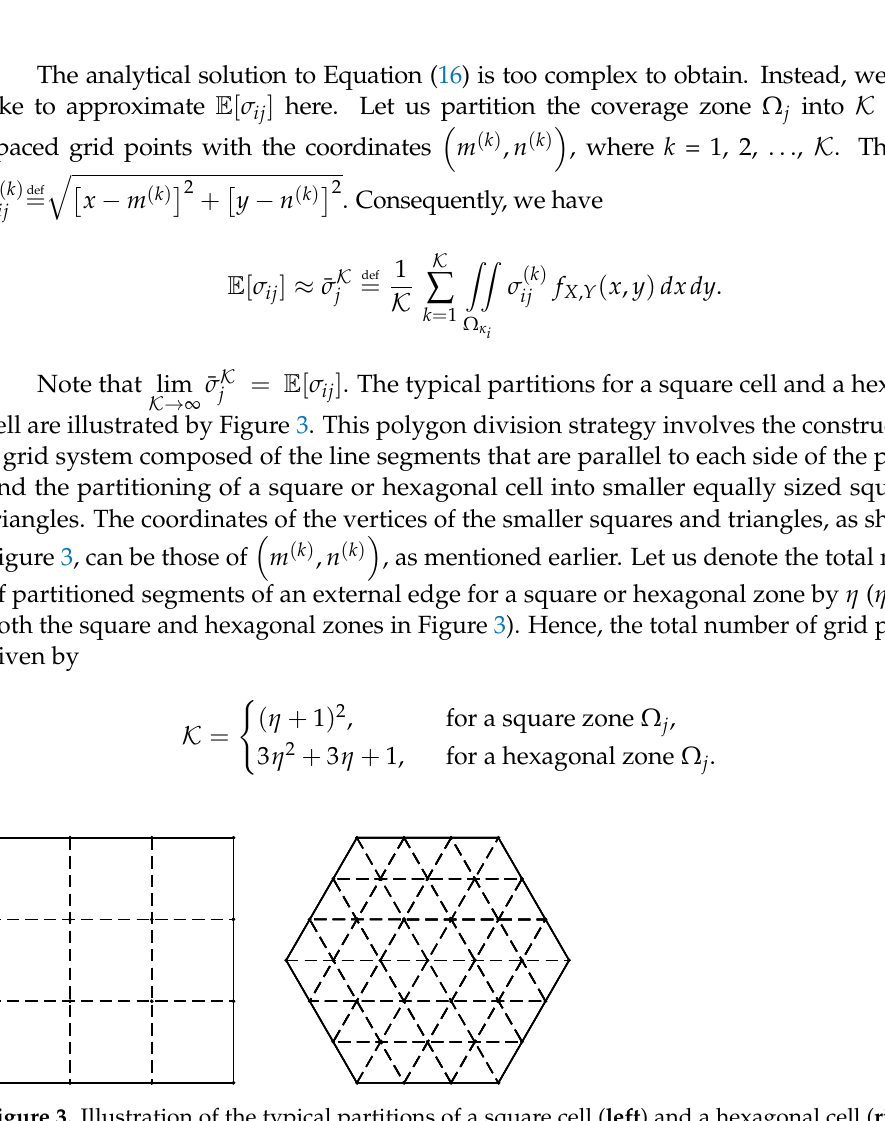
Figure 3. Illustration of the typical partitions of a square cell ( left ) and a hexagonal cell ( right ) for η = 3.